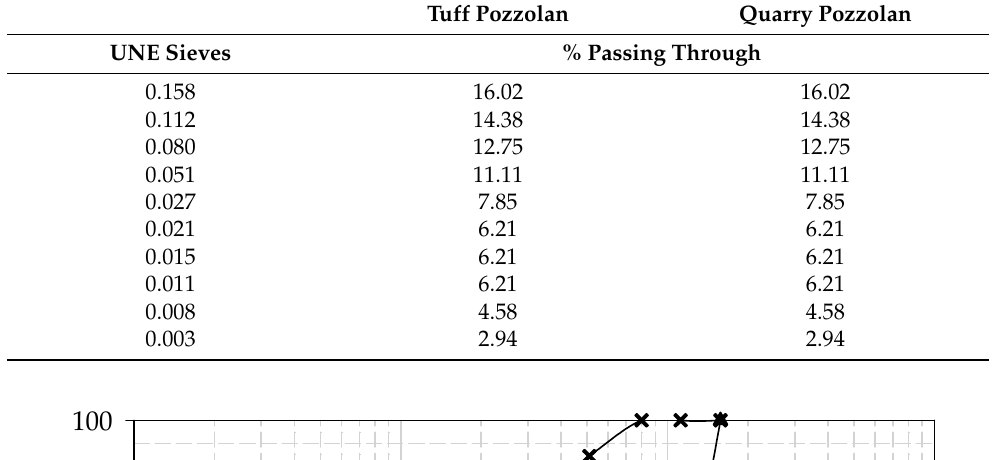
Table 3. Particle size analysis of additives by wet sieving. Table 5. Origin, size, and absorption coefficient of the aggregates.